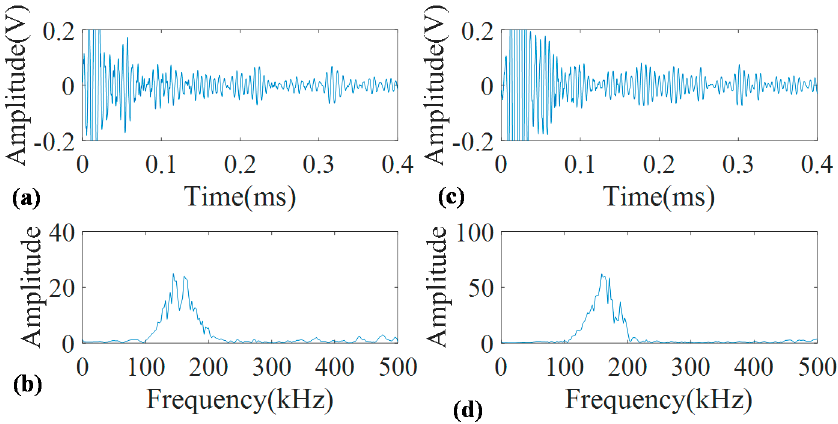
Figure 9. Guided wave signals measured at 160 kHz for concrete covered pristine pipe ( a ) with its FFT ( b ); and concrete covered corroded pipe ( c ) with its FFT ( d ).